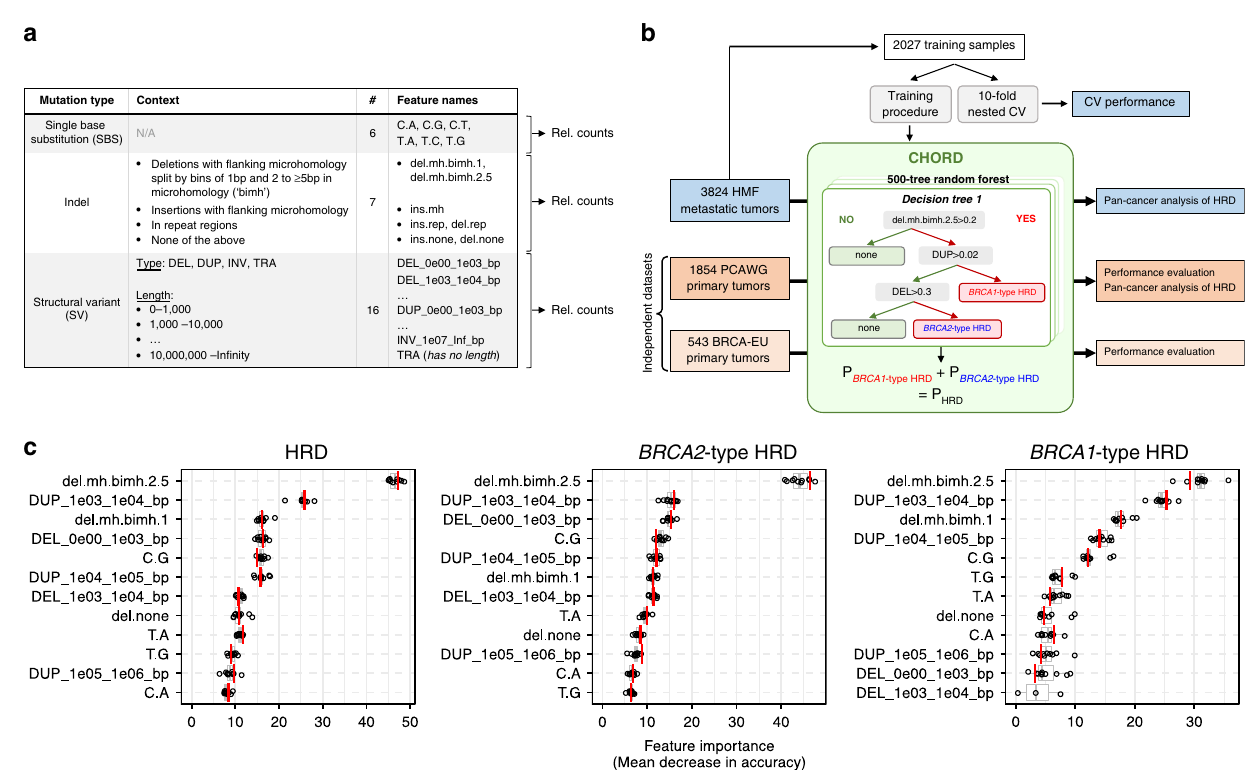
Fig. 1 CHORD is a random forest Classi fi er of HOmologous Recombination De fi ciency able to distinguish between BRCA1 - and BRCA2 -type